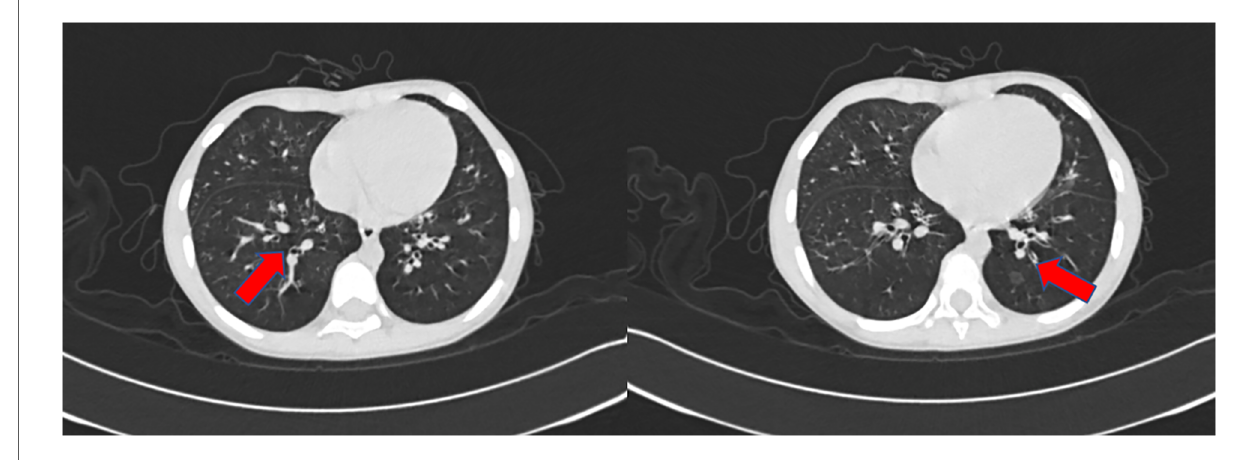
FIGURE 3 The CT scan of the chest performed 29 days after admission showed a thickening of airway